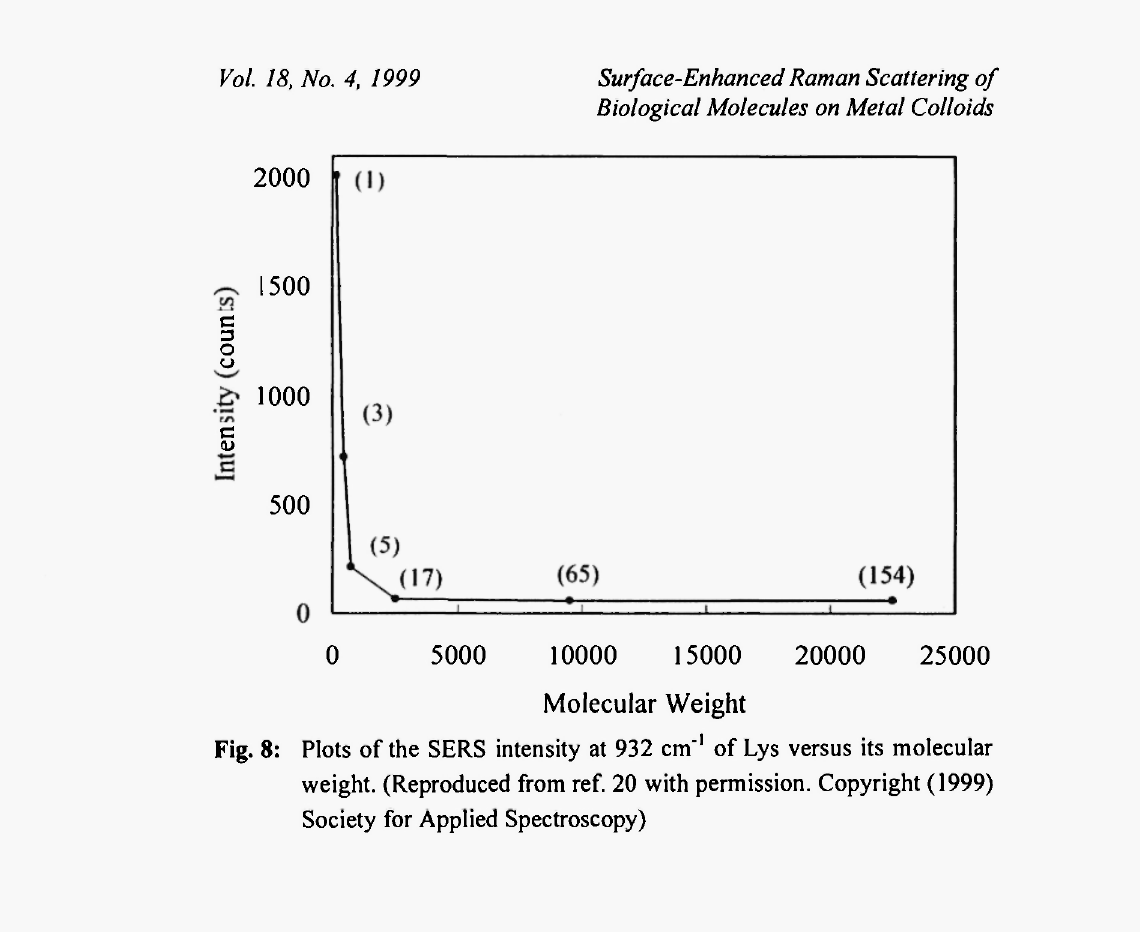
Fig. 8: Plots of the SERS intensity at 932 cm" 1 of Lys versus its molecular weight. (Reproduced from ref. 20 with permission. Copyright (1999) Society for Applied